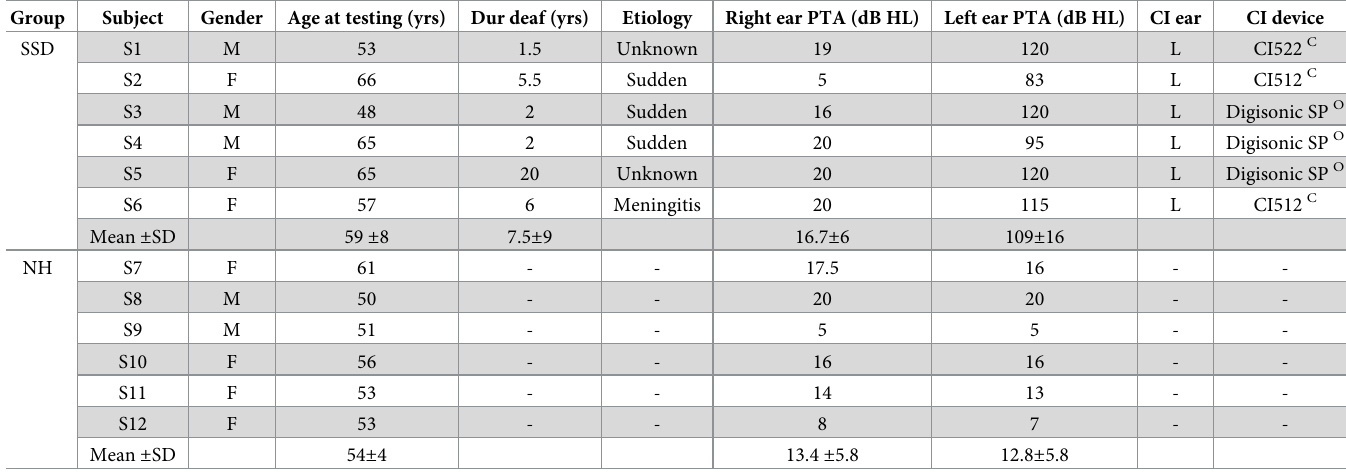
Table 1. Demographic information for SSD-CI